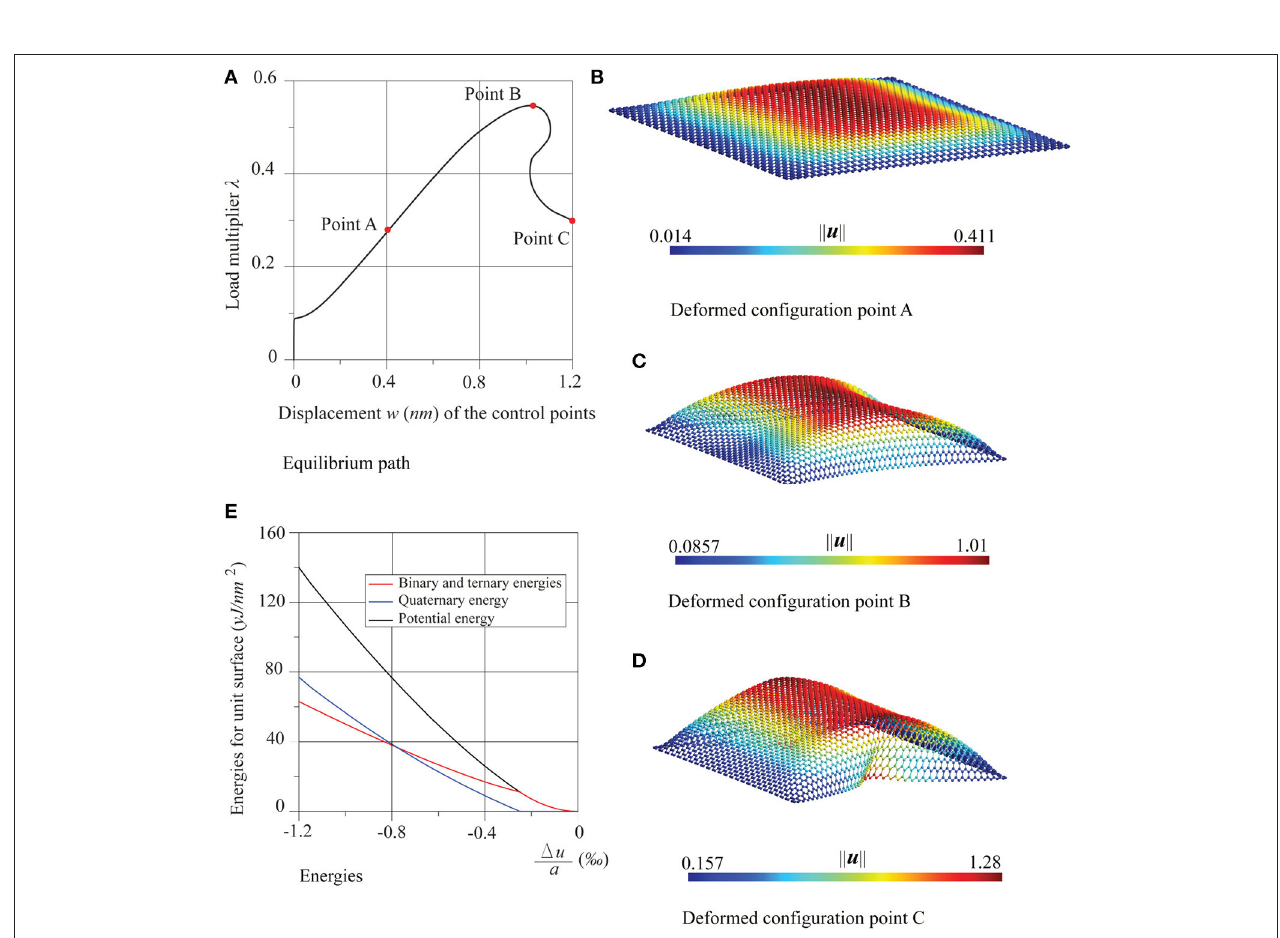
FIGURE 5 | Graphene sheet with four supported edges under compression in the zigzag direction: (A) equilibrium path, (B–D) deformed configurations at the points A , B and C , and (E) energies trends.